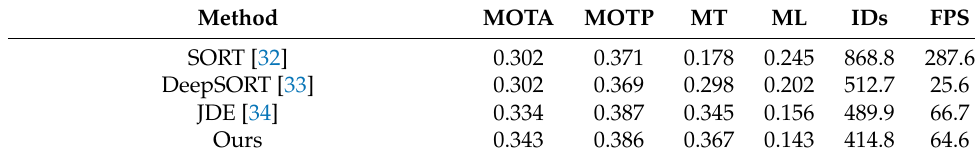
Table 6. The tracking results on UA-DETRAC